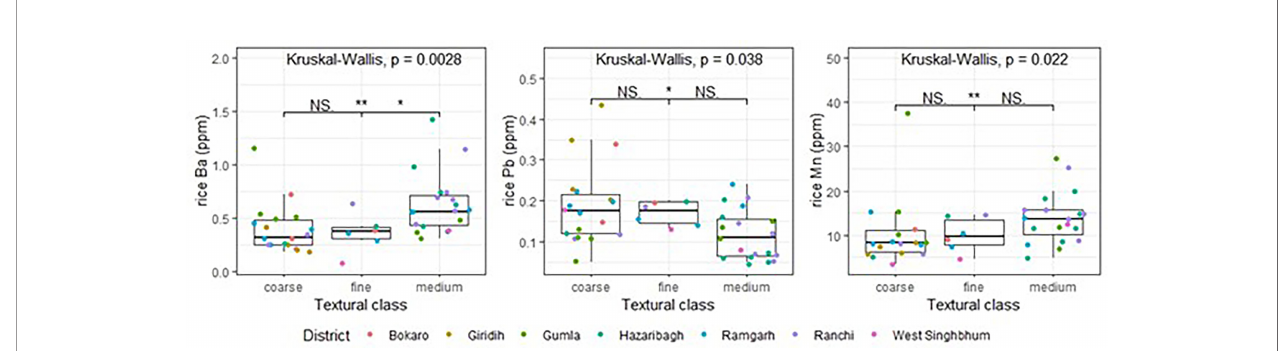
FIGURE 8 | Rice Ba, Pb and Mn concentrations by textural class. NS, not signi fi cant; * signi fi cant at the 0.05 signi fi cance level; ** signi fi cant at the 0.01 signi fi cance level.